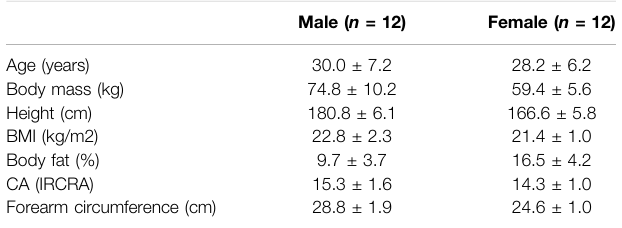
TABLE 1 | Anthropometric data and climbing ability of male ( n = 12) and female ( n = 12) participants.